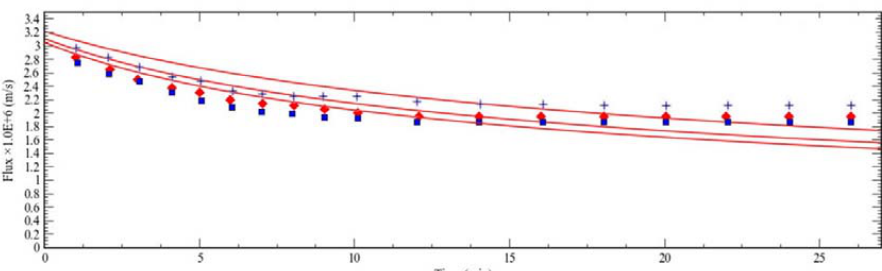
Fig. 7: Flux vs. time data for skim milk through Pellicon cassette ultrafiltration membrane module compared to the cake formation model at different temperatures.